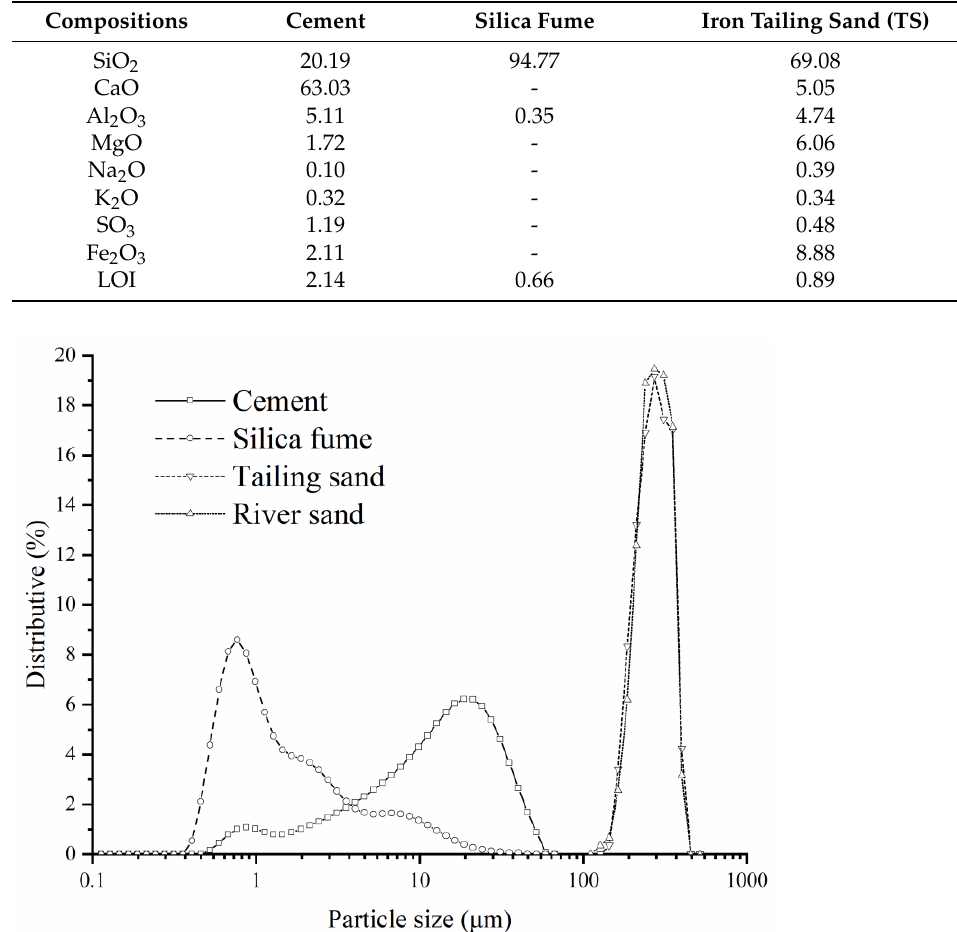
Table 1. Chemical analysis of the cementitious materials and iron tailings (%).